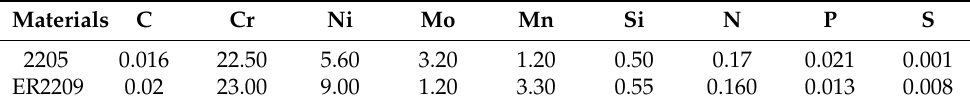
Table 1. The chemical compositions of 2205 duplex stainless steel and filler wire (wt %).